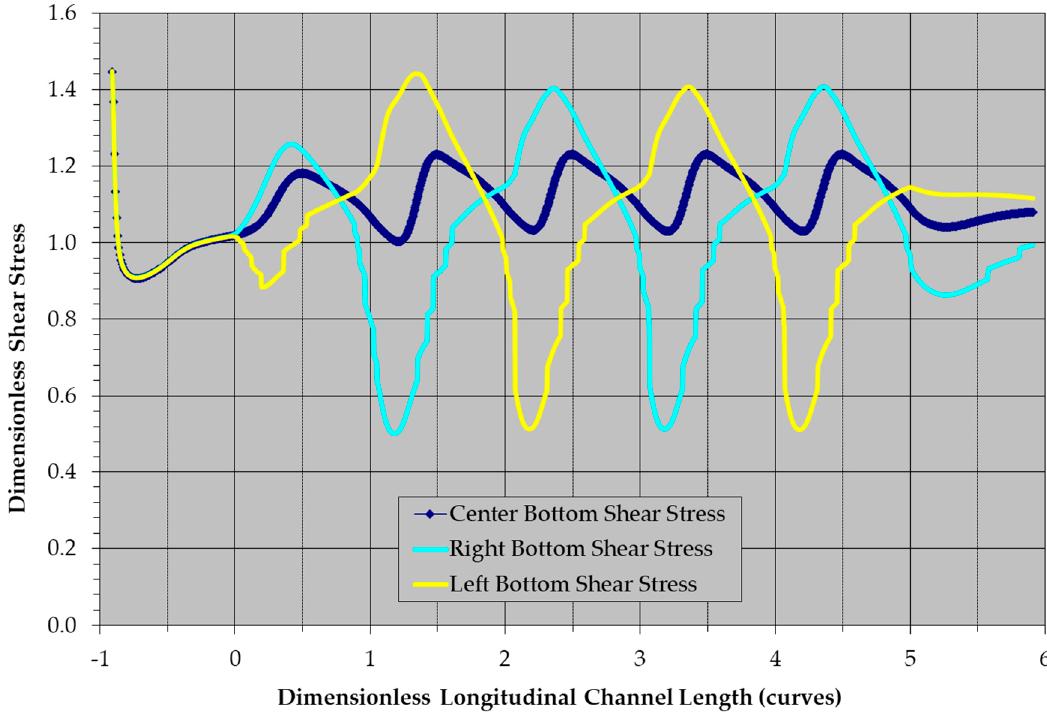
Figure 31. Dimensionless shear stress along the channel centerline, left and right banks for Simulation